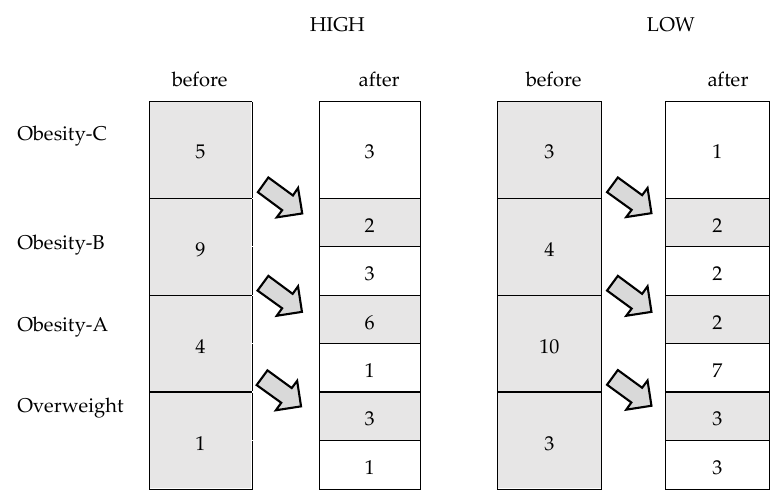
Figure 2. Changes in the weight status categories among the participants after the intervention period. Table 2. Participant characteristics before and after the 24 weeks of intervention.